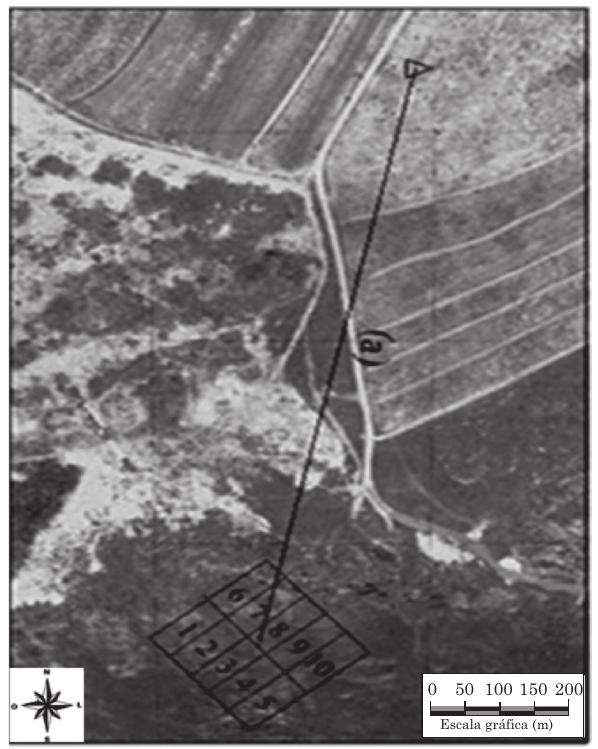
Figure 1. Google Earth image of the study area (18 o 10’ S and 43 o 30’ W) and the distribution of the 10 sampled plots in a 1-ha area, at a distance of 488 m (a) from the weather station Juscelino Kubitschek (